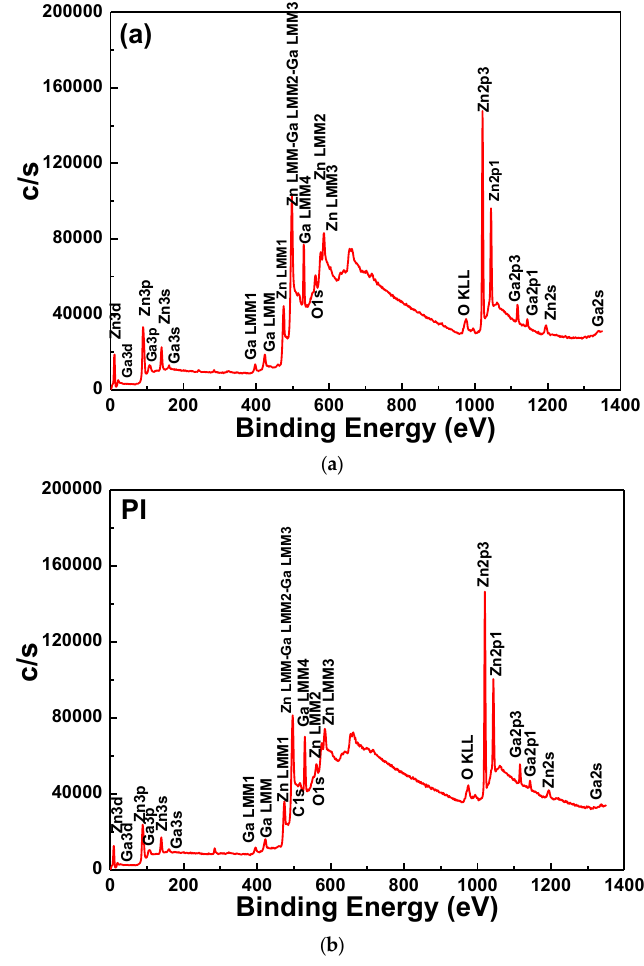
Figure 7. Typical widescan spectrum of the GZO thin films as a function of used substrates. ( a ): glass; ( b ): PI.